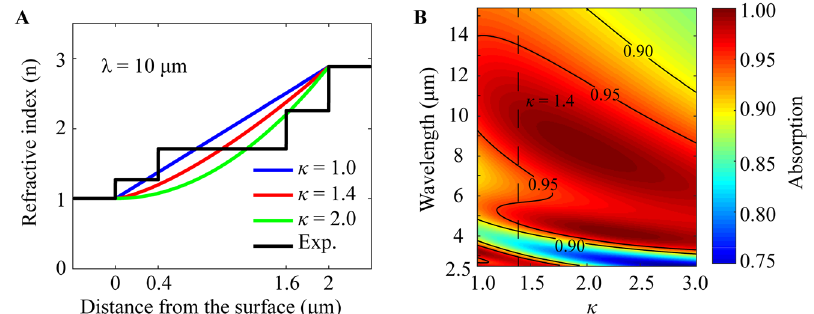
Figure 3: (A) Refractive index as a function of depth for continuously changing materials with different κ (blue, red, and green lines) and the actual pro fi le (black line) of the fabricatedbroadbandabsorber.(B)Contour plot of the absorption spectra as a function of κ for the device. The color scale indicates absorption from 75 (blue) to 100% (red).